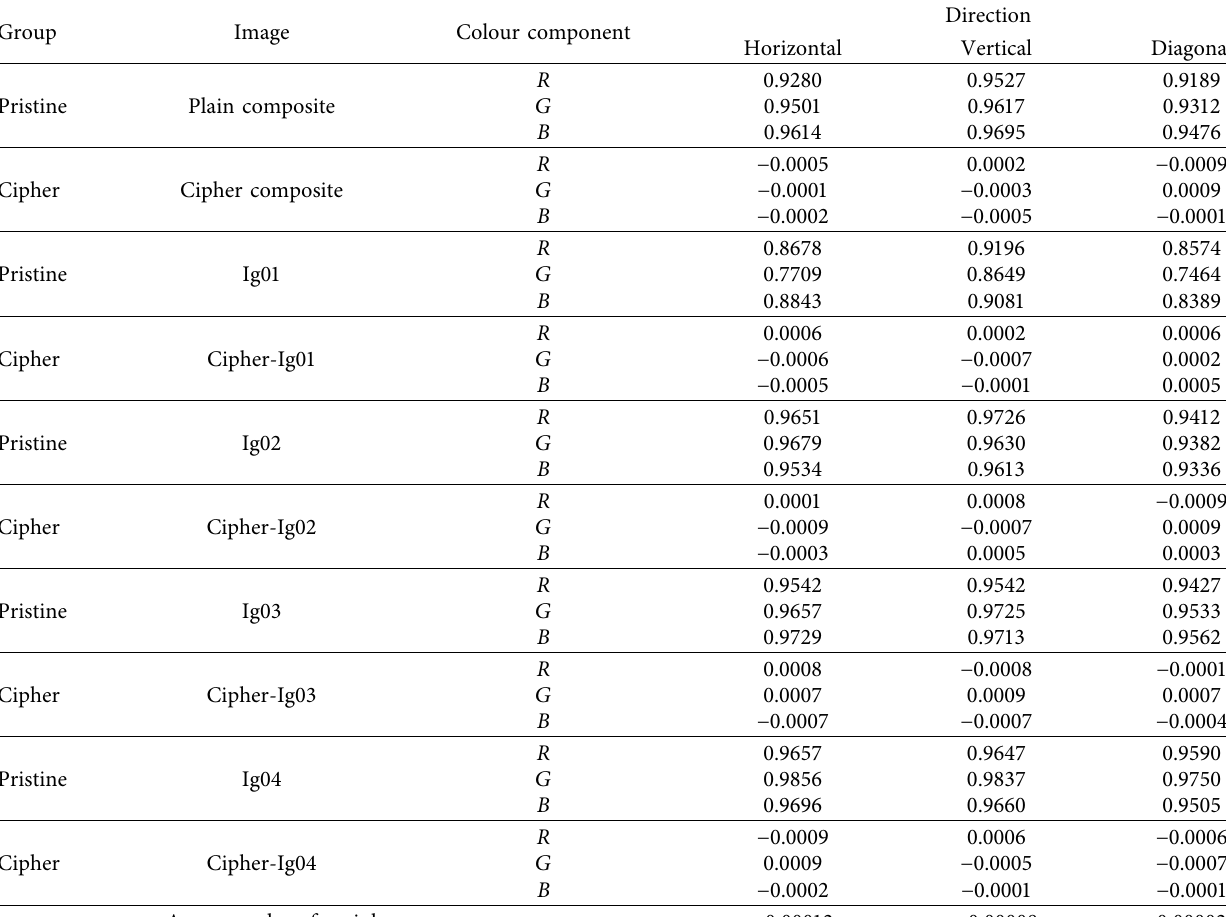
Figure 5: Pristine (or input) images (a) Ig01, (b) Ig02, (c) Ig03, and (d) Ig04 and their respective ciphered versions (e) Cipher-Ig01, (f) Table 1: Correlation coefficient test for the pristine and cipher groups for input and composite